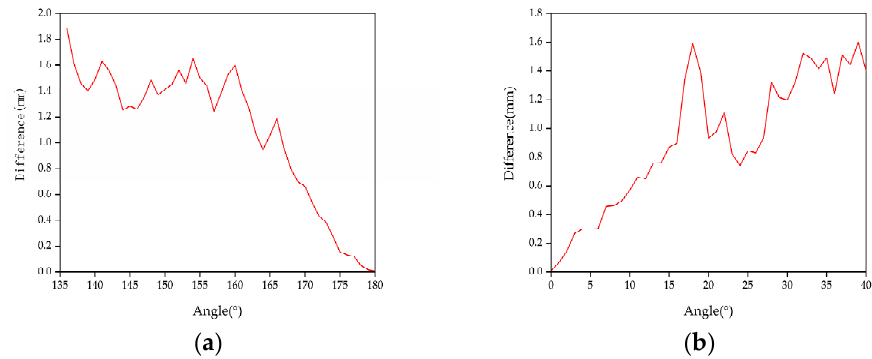
Figure 7. Tilt angle measurement results: ( a ) 0°~40° and ( b ) 136°~180°.